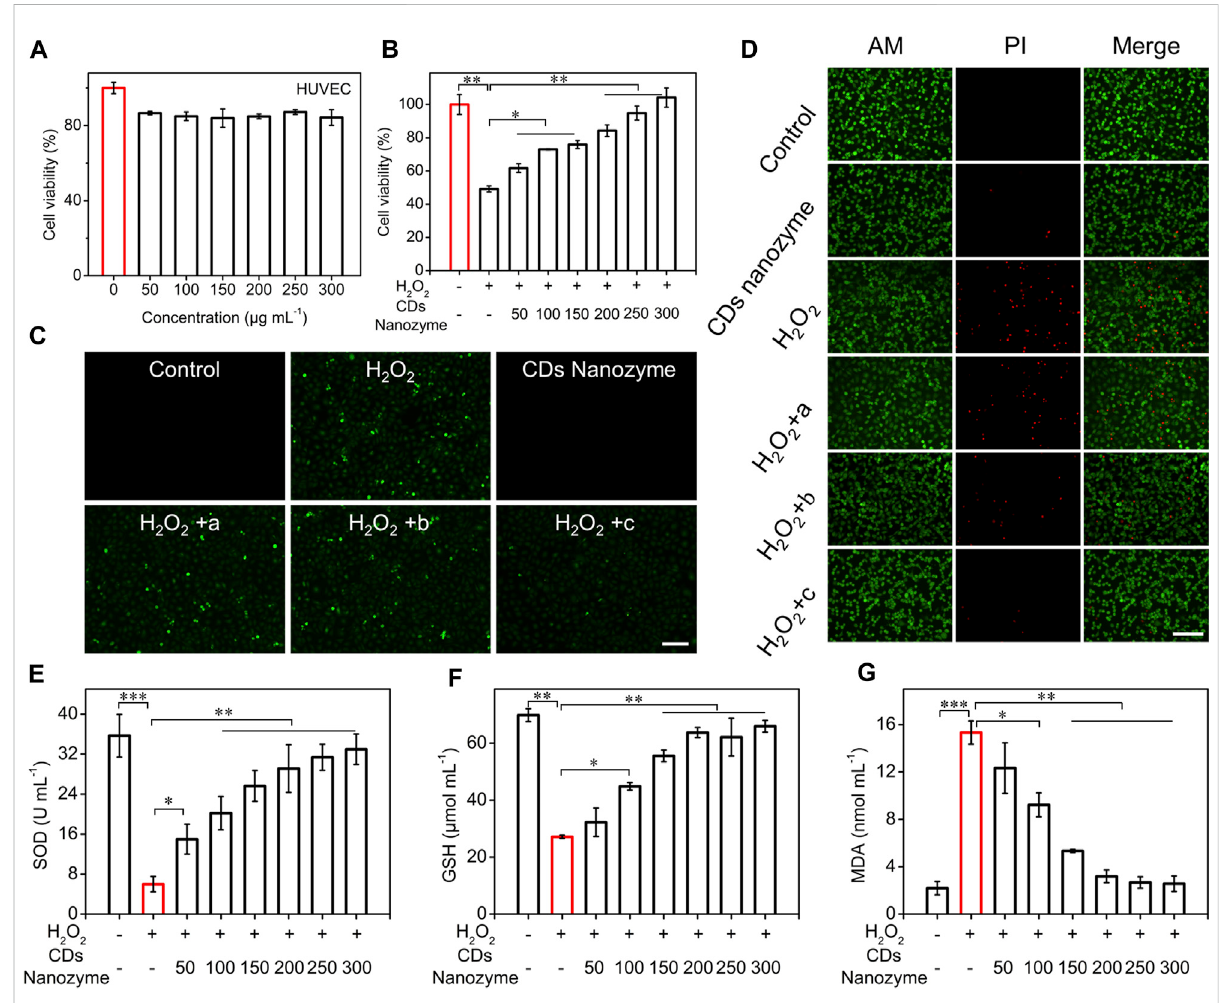
FIGURE 3 (A) Cell viability of HUVEC cells after treatment with various concentrations of CDs nanozyme for 24 h. (B) The protective effects of CDs nanozyme on H 2 O 2 -induced oxidative stress in HUVEC cells (The concentration of H 2 O 2 is 300 μ mol L − 1 ). (C) Fluorescence images of HUVEC cells with ROS staining by DCFH-DA probe (a: 100 μ g ml − 1 CDs nanozyme; b: 200 μ g ml − 1 CDs nanozyme; c: 300 μ g ml − 1 CDs nanozyme, scale bar